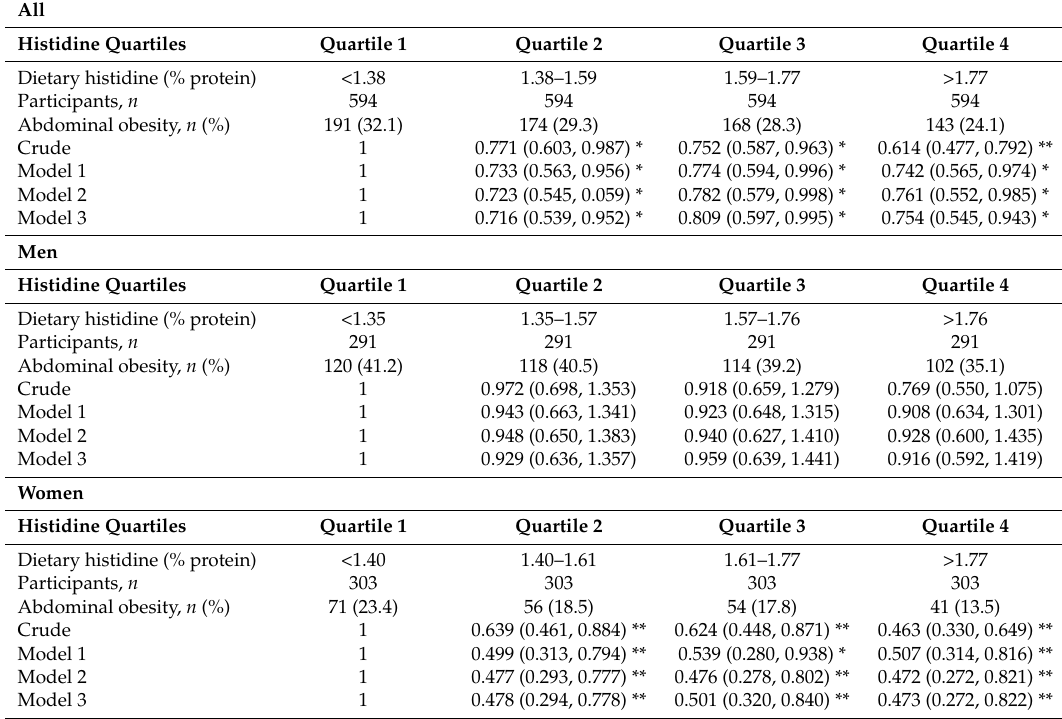
Table 4. Multivariable-adjusted Odds ratio (OR) and 95% confidence interval (CI) of abdominal obesity by quartile of dietary